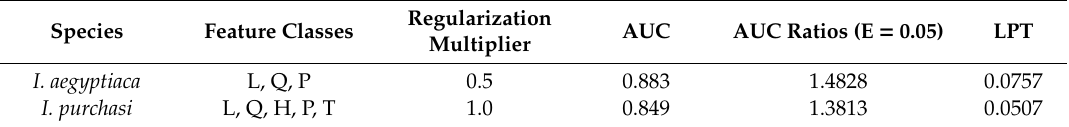
Figure 1. The results of ENMeval of R package for ( A ) I. aegyptiaca and ( B ) I. purchase . Table 2. Important values for the MaxEnt